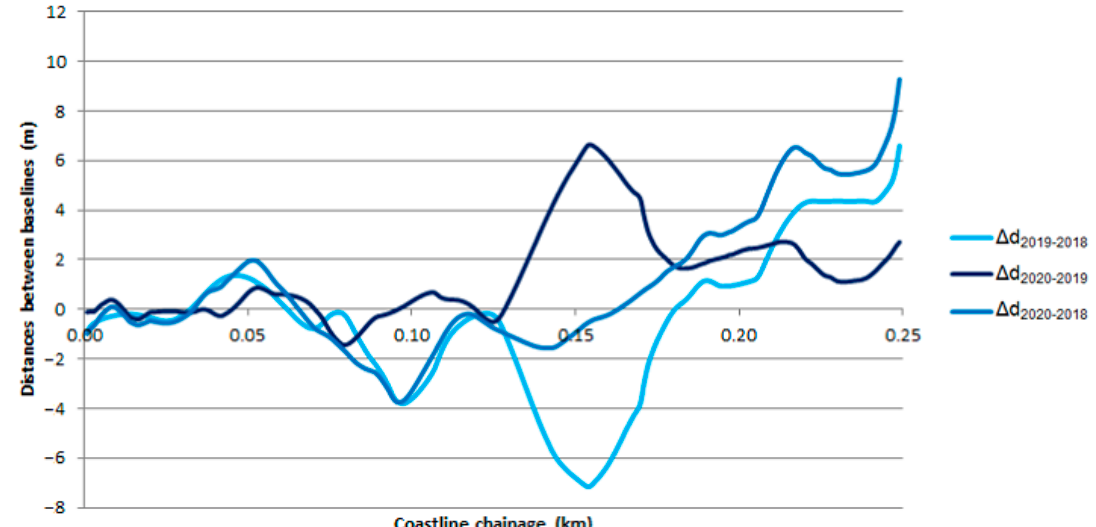
Figure 9. Distances between TSBs of the waterbody located close to the Vistula Ś mia ł a River mouth measured with the hydrographic method in 2018–2020.